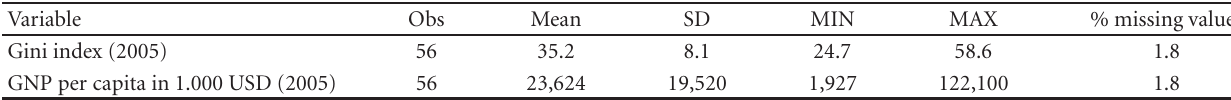
Table 1: Variables on country level ( n = 57,